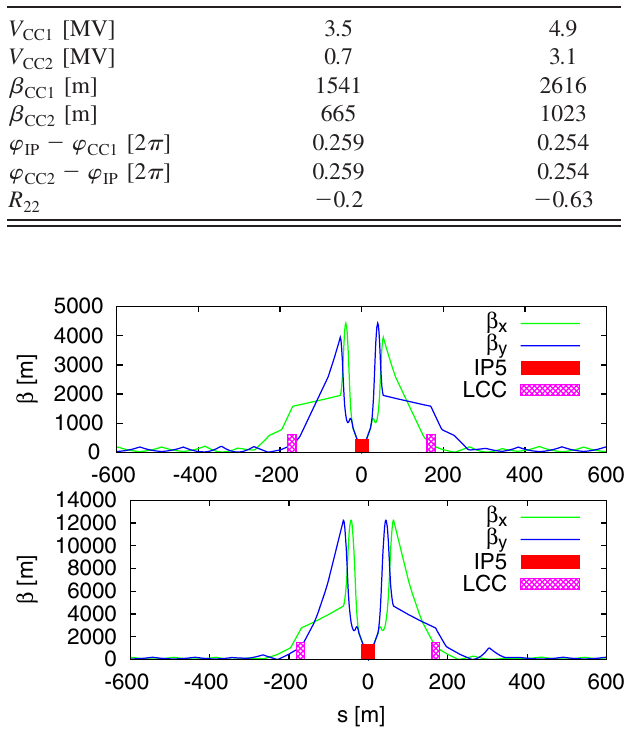
FIG. 3. (Color) Optics parameters for the local crab scheme in LHC IR5: nominal LHC collision optics (top) and lowbetamax collision optics (bottom). IP5 is at s ¼ 0 .